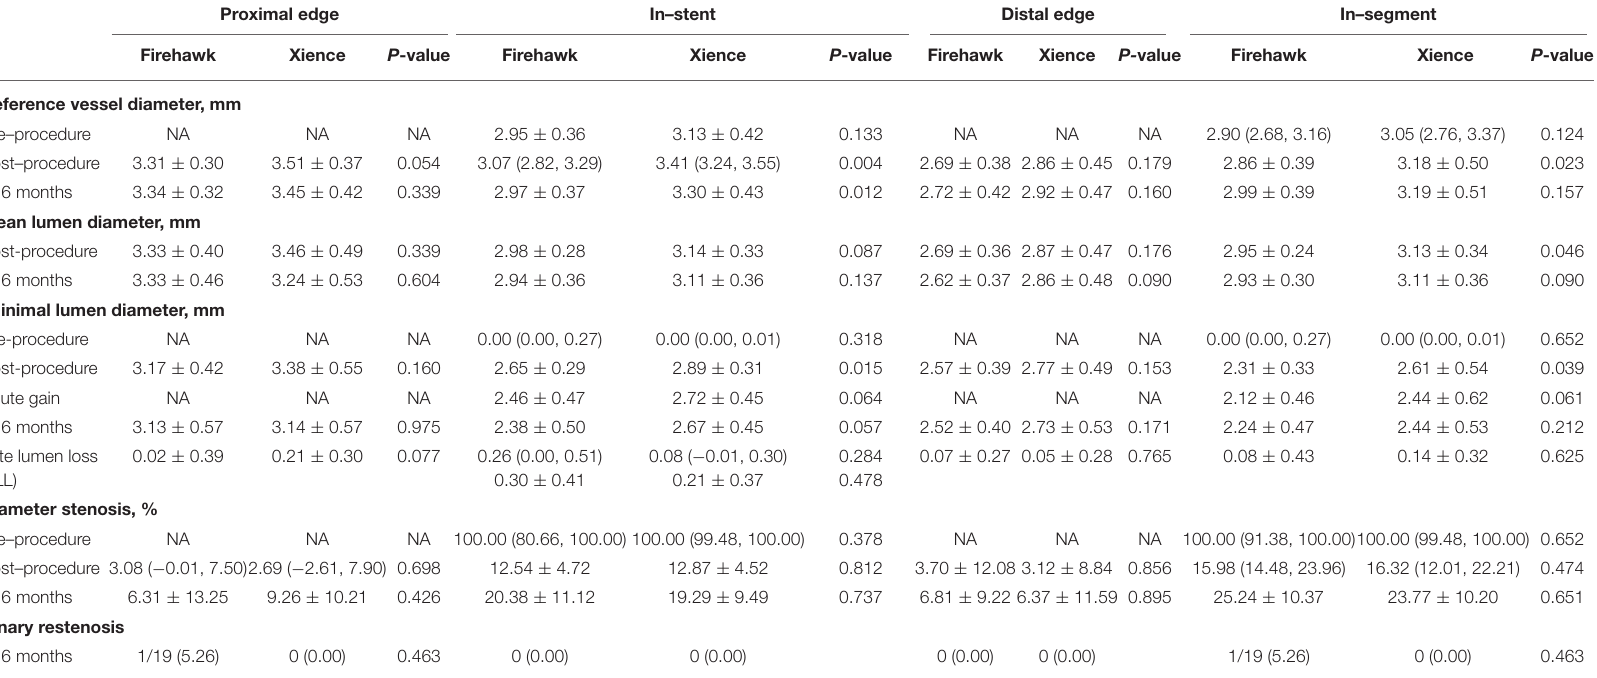
TABLE 3 | Quantitative coronary angiographic